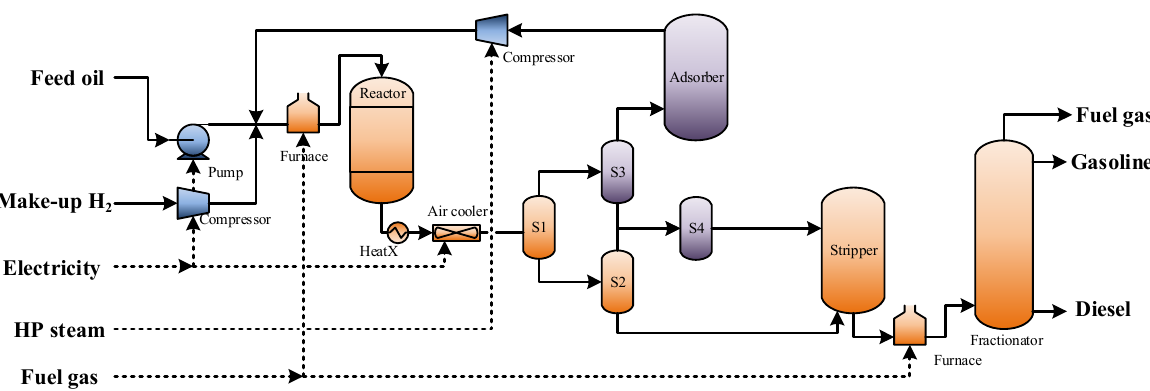
Figure 1. Flowchart of a HDT unit (S1 to S4 mean separator 1 to separator 4).